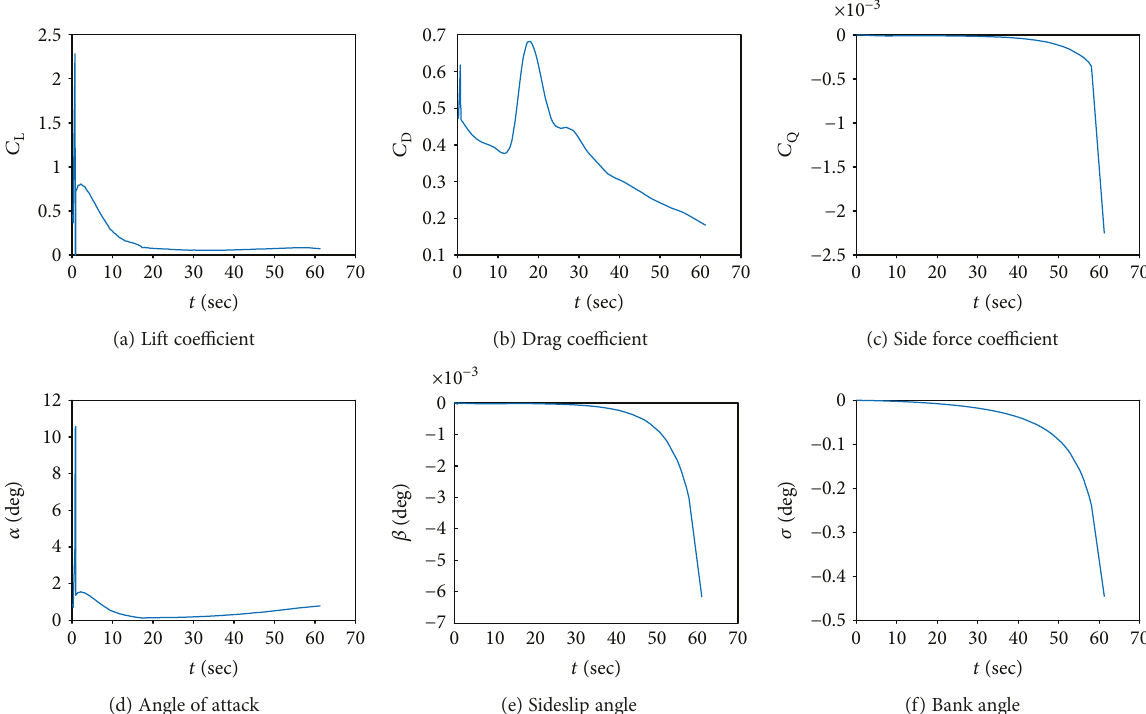
Figure 14: Aerodynamic angles and coe ffi cients in the thrust arc for the con fi guration with l =7.29 m and d =0.36m (near radial